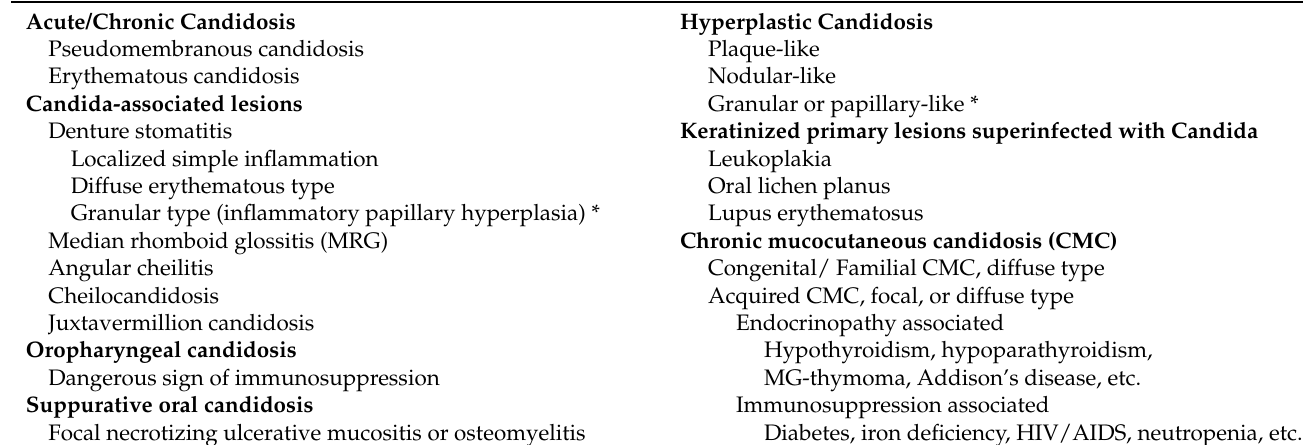
Figure 9. ( A ) The change of chronic oral ulcers associated with oral candidosis covered by a thick shiny organized biofilm with grayish color over lower labial mucosa, anterior gingiva, and tongue tip over 1 year in a critically ill 68-year-old woman with osteoarthritis and Reiter’s syndrome on many medications, including prednisolone. ( B ) Progressive resolution of the lesion was achieved by initial prescription with fluconazole 2 weeks later ( B ), 4 weeks later ( C ), and then changed to nystatin tablets and complete response within 6 weeks ( D ). Table 3. New classification of oral candidosis by clinicopathological features and